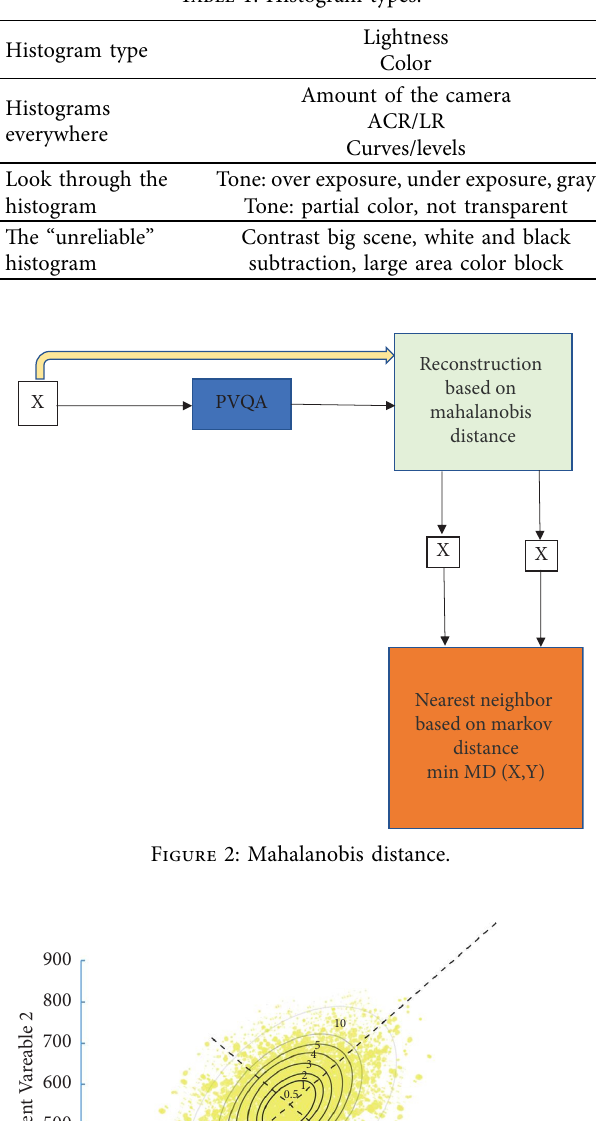
Table 1: Histogram types.